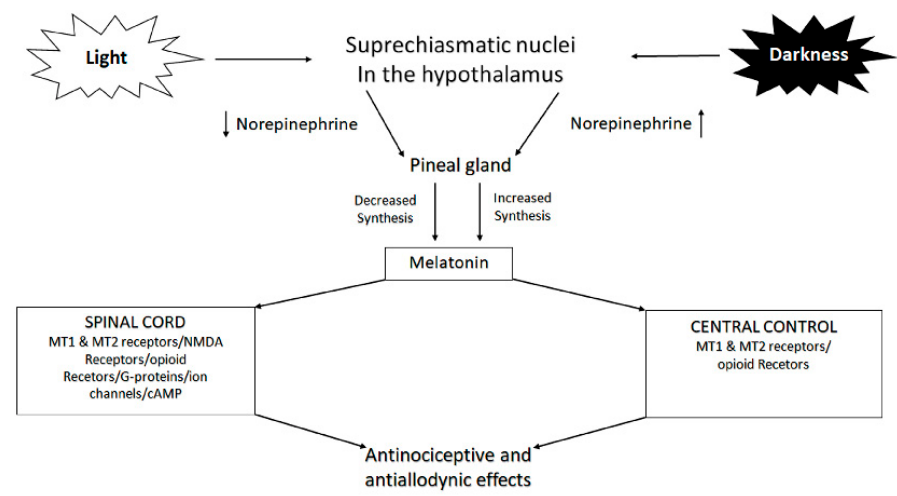
Figure 1. Control of melatonin synthesis in the pineal gland by light-dark cycles; melatonin’s antinociceptive and antiallodynic effects. Abbreviations: NMDA: N-methyl-D-aspartate, cAMP: Cyclic adenosine monophosphate; MT1: melatonin receptor 1; MT2: melatonin receptor 2